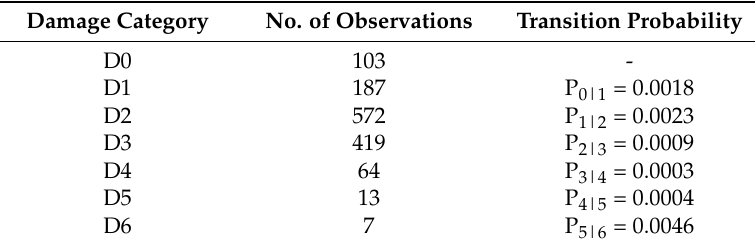
Table 5. Calibrated transition probabilities.